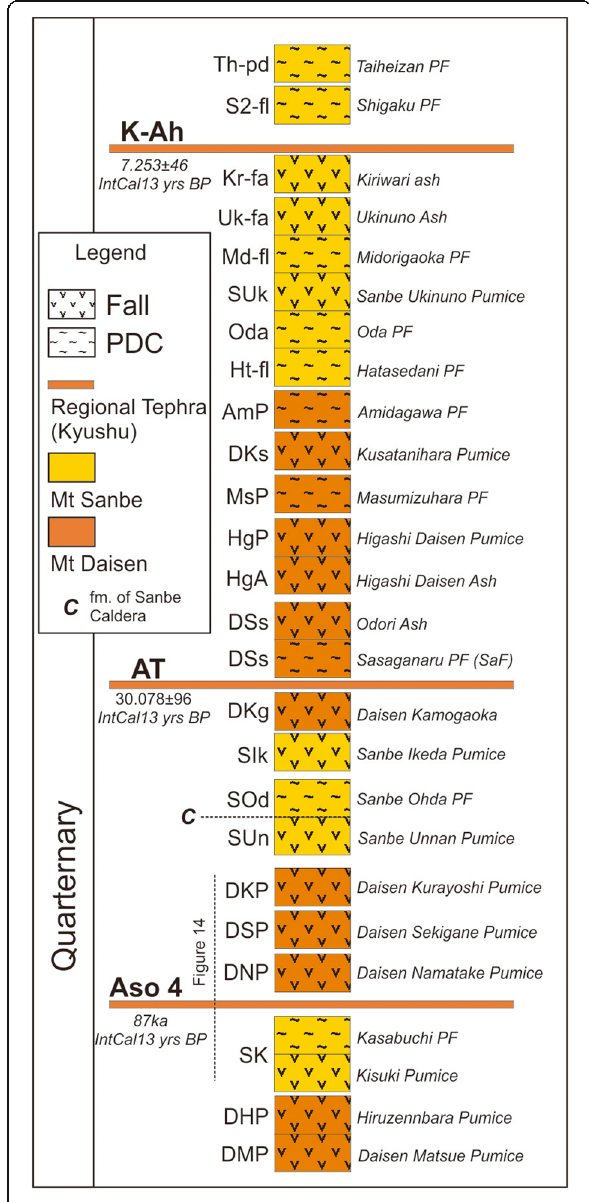
Fig. 12 Combined stratigraphic record from Daisen and Sanbe Volcano showing major tephras and large deposits formed by pyroclastic density currents (Albert et al.